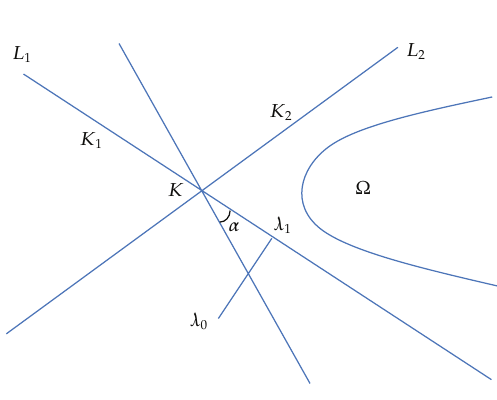
Figure 1: Figure of Lemma 3.1 (cid:8) ii (cid:7)